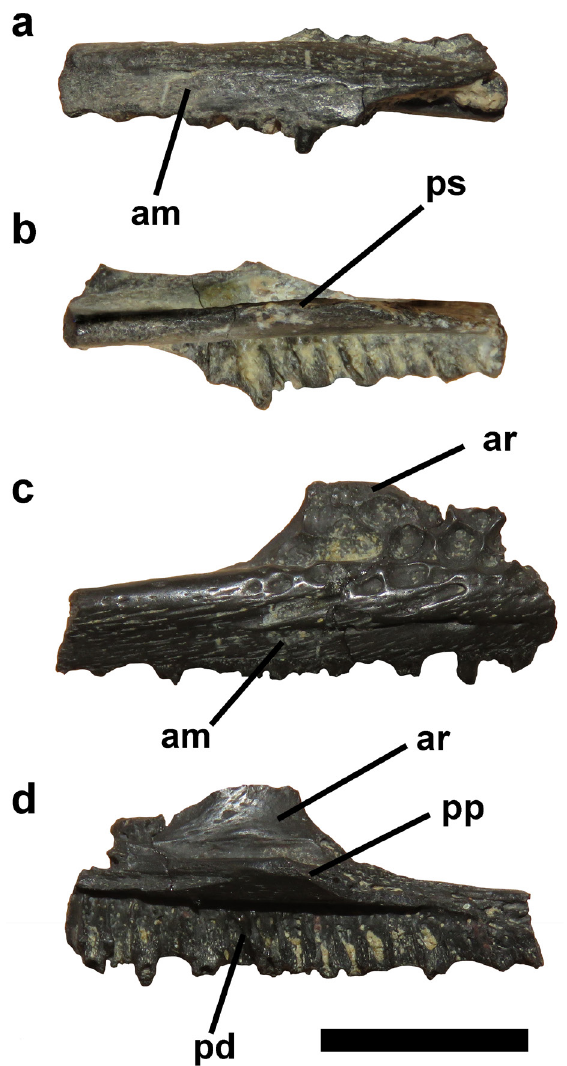
Figure 7. Indeterminate Calyptocephalellidae. a-d, LIEB-PV 8006-8007, right maxillae in a,c, lateral; b,d, medial views. References: am, alveolar margin; ap, asceding ramus; pp, pterygoid process; ps, palatine shelf. Sclae bar: 1